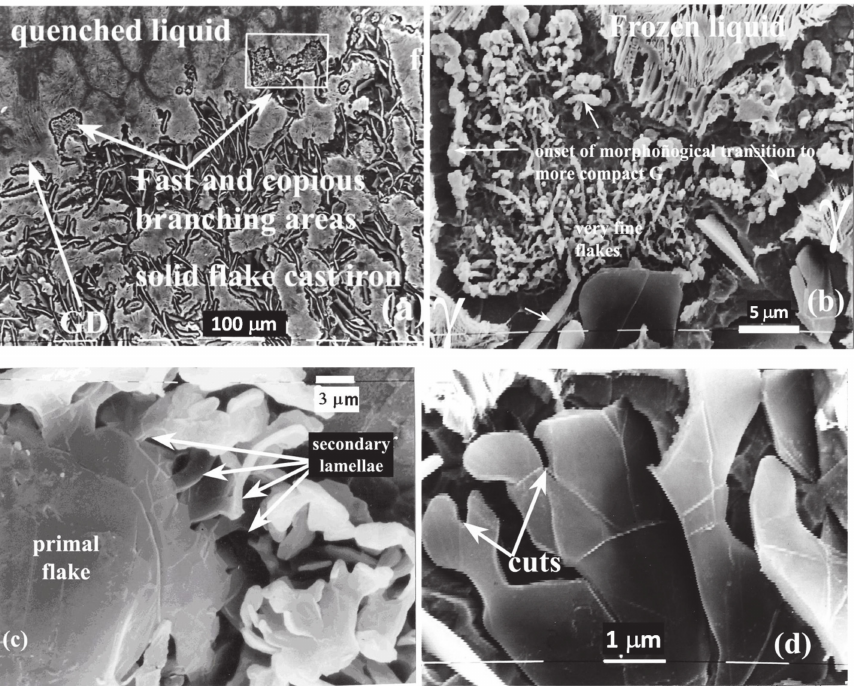
Figure 10. SEM images of the sequence of transition from LAG to undercooled G; ( a ) panoramic view of LAG eutectic front/ liquid interface; ( b ) magnification of marked zone of ( a ); ( c ) detail of branching; ( d ) details of twinned undercooled G showing intense